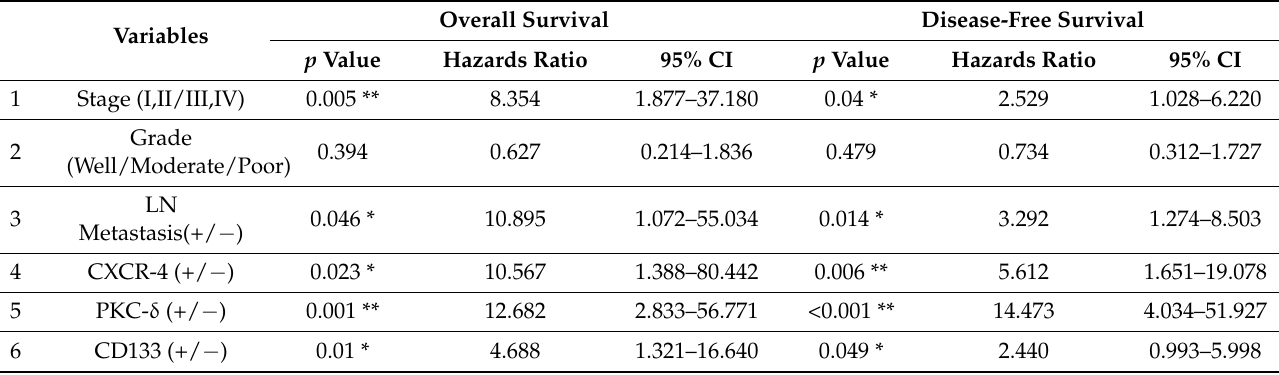
Table 5. Cox univariate proportional hazards regression analysis.